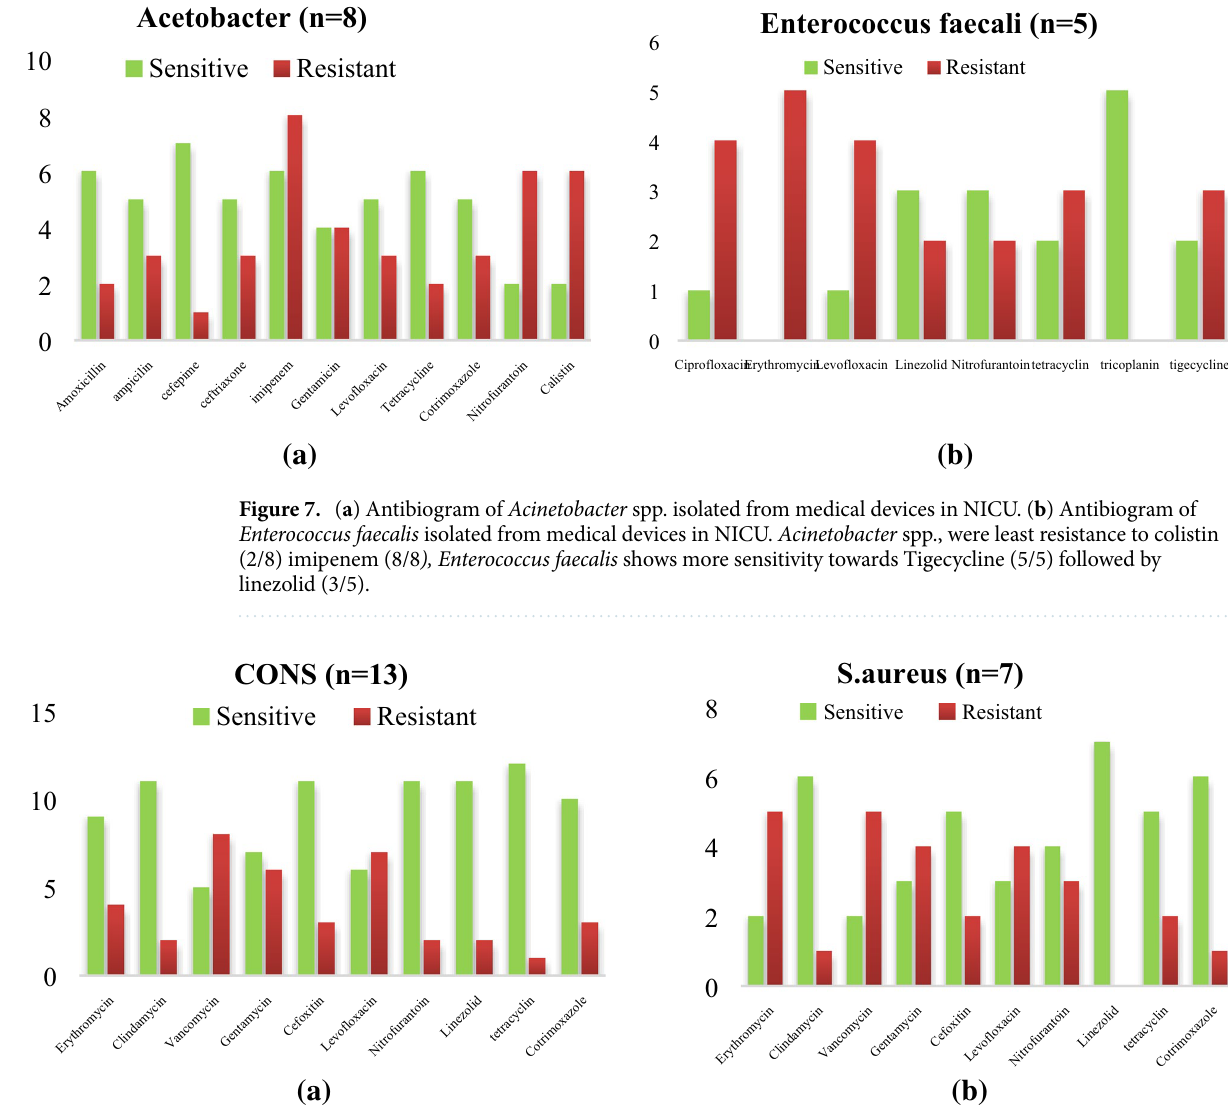
Figure 8. ( a ) Antibiogram of CoNS isolated from anterior nares of health care workers. ( b ) Antibiogram of S.aureus isolated from anterior nares of health care workers in NICU. CoNS as the predominant isolates shows a least resistant to tetracycline (1/13) and linezolid (2/13) with 3 MRSA isolated. For S.aureus , linezolid (8/8) susceptibility was observed with (2/8) MRSA the following rates: 63.2%, 63.2%, 34.2%, 2.6% and 2.6%, respectively 28 . Similar study is done for detection of microbes in hands of health care workers for which swabs from hands were taken and cultured. All participants were found to be colonized with CoNS (12/30; Table 2), S.aureus (6/30 Table 2), MRSA was found in 4 HCW (Table 2) where antibiotic susceptibility pattern revealed their maximum sensitivity for vancomycin, tetracycline, linezolid and co trimoxazole and their resistance for Clindamycin, erythromycin and nitro furan. Similarly a sum of 30 nasal and hand swabs were also collected from health care associates of NICU, which shows the pres- ence of CoNS (13/30 Table 5) and S.aureus (8/30; Table 5) from the anterior nares and CoNS (4/30 Table 6), S. aureus (5/30 Table 6), Acinetobacter spp. (5/30 Table 6), Klebsiella spp. (4/30 Table 6), Bacillus spp. (8/30 Table 6) isolates from hand sampling. Antibiogram of CoNS depicted linezolid, vancomycin and nitrofurantoin as the most susceptible antibiotic while erythromycin and Clindamycin the most resistant one. Antibiogram from hand samples showed sensitivity of CoNS and S.aureus to linezolid, vancomycin and tetracycline and resistance for erythromycin, levofloxacin and co trimoxazole. Colistin sensitivity for Acinetobacter spp. and Klebsiella spp. remains highest. Clinical samples of blood specimen from NICU shows maximum Candida spp. (60/135), fol- lowed by Acinetobacter baumanii (21/135), K. Pneumoniae (20/135) (Fig. 11). From PICU, blood specimen from